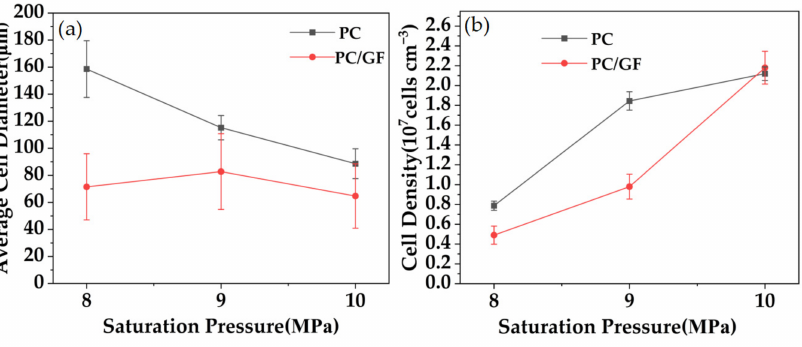
Figure 9. Pure PC and 15% GF loaded PC/GF at different pressures: ( a ) changes in mean cell diameter and ( b ) changes in cell density.